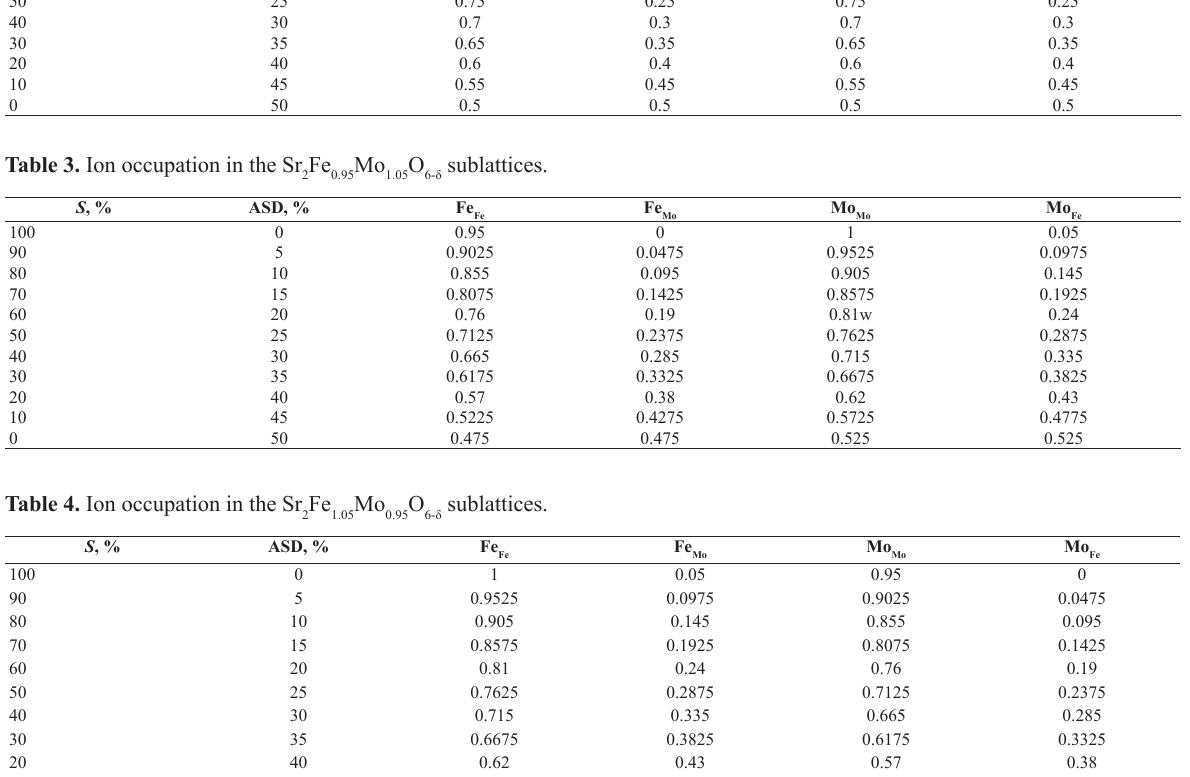
Table 3. Ion occupation in the Sr